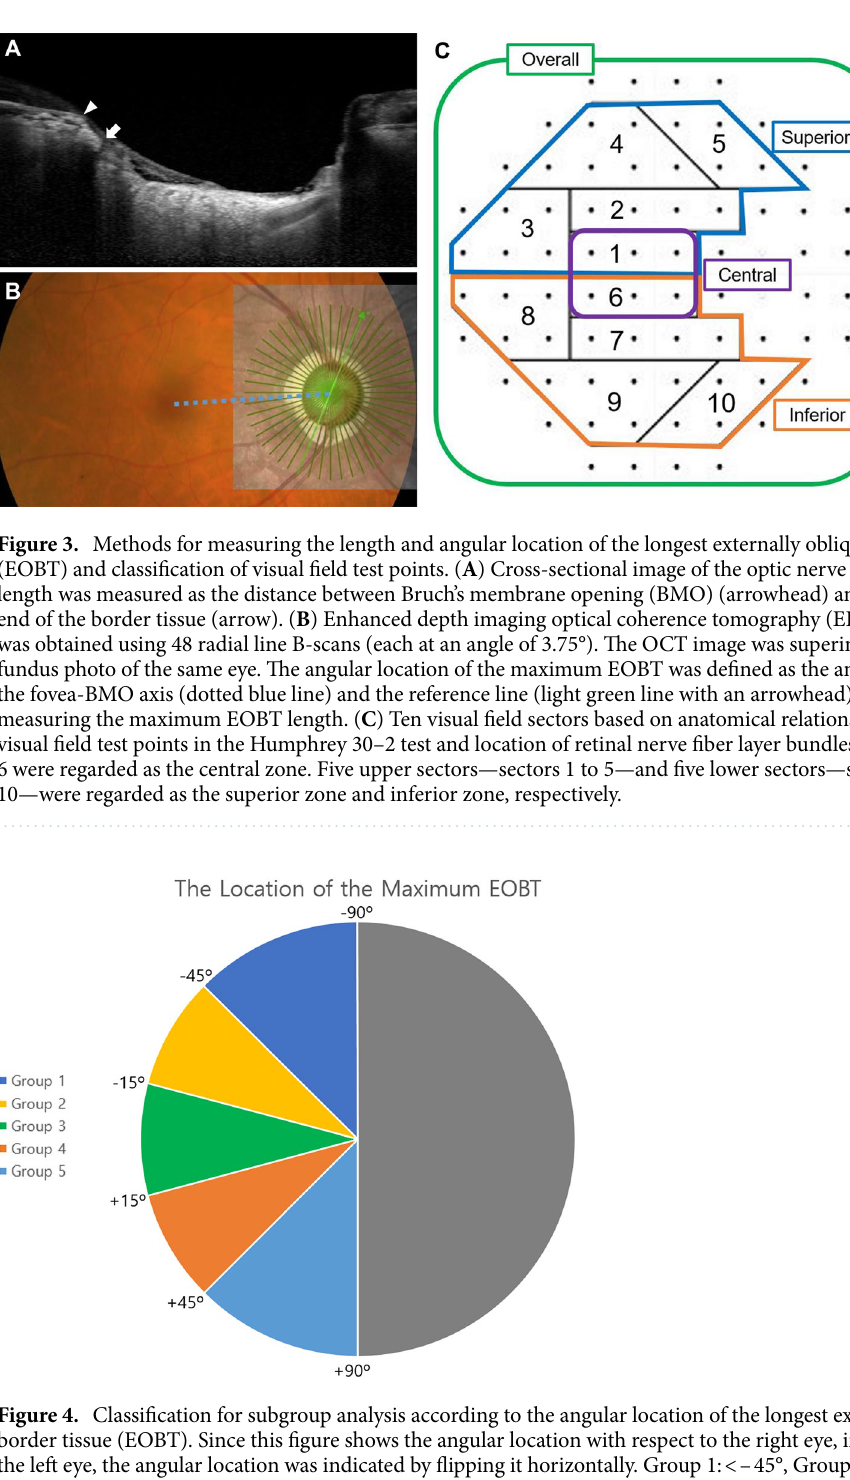
were against the group without VF progression. In multivariate analysis, stepwise variable selection procedures based on the Akaike Information Criterion were implemented. ORs are presented as means with 95% confidence intervals. Two-sided P values are reported for all tests; P values less than 0.05 were considered statistically sig- nificant.